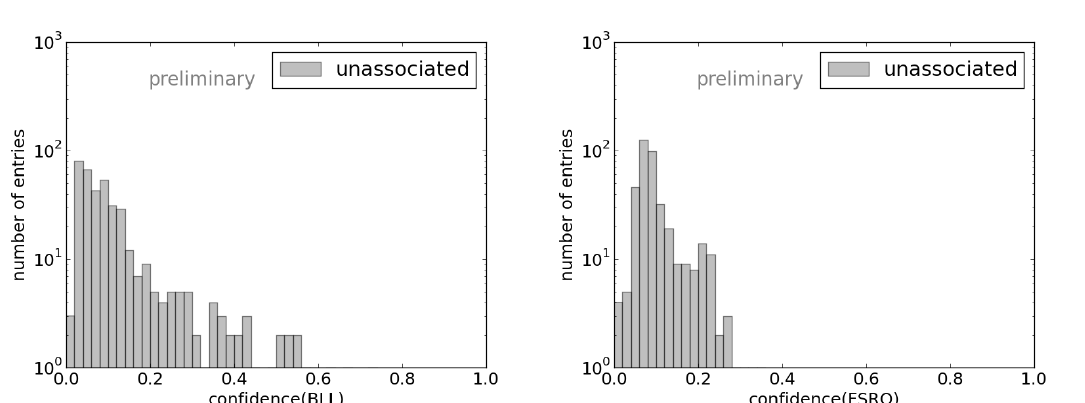
Figure 7. Confidence distribution for the BLL ( left ) and the FSRQ class ( right ). The classification model is applied to the data set of unassociated sources extracted from the 3FGL and the 1SXPS